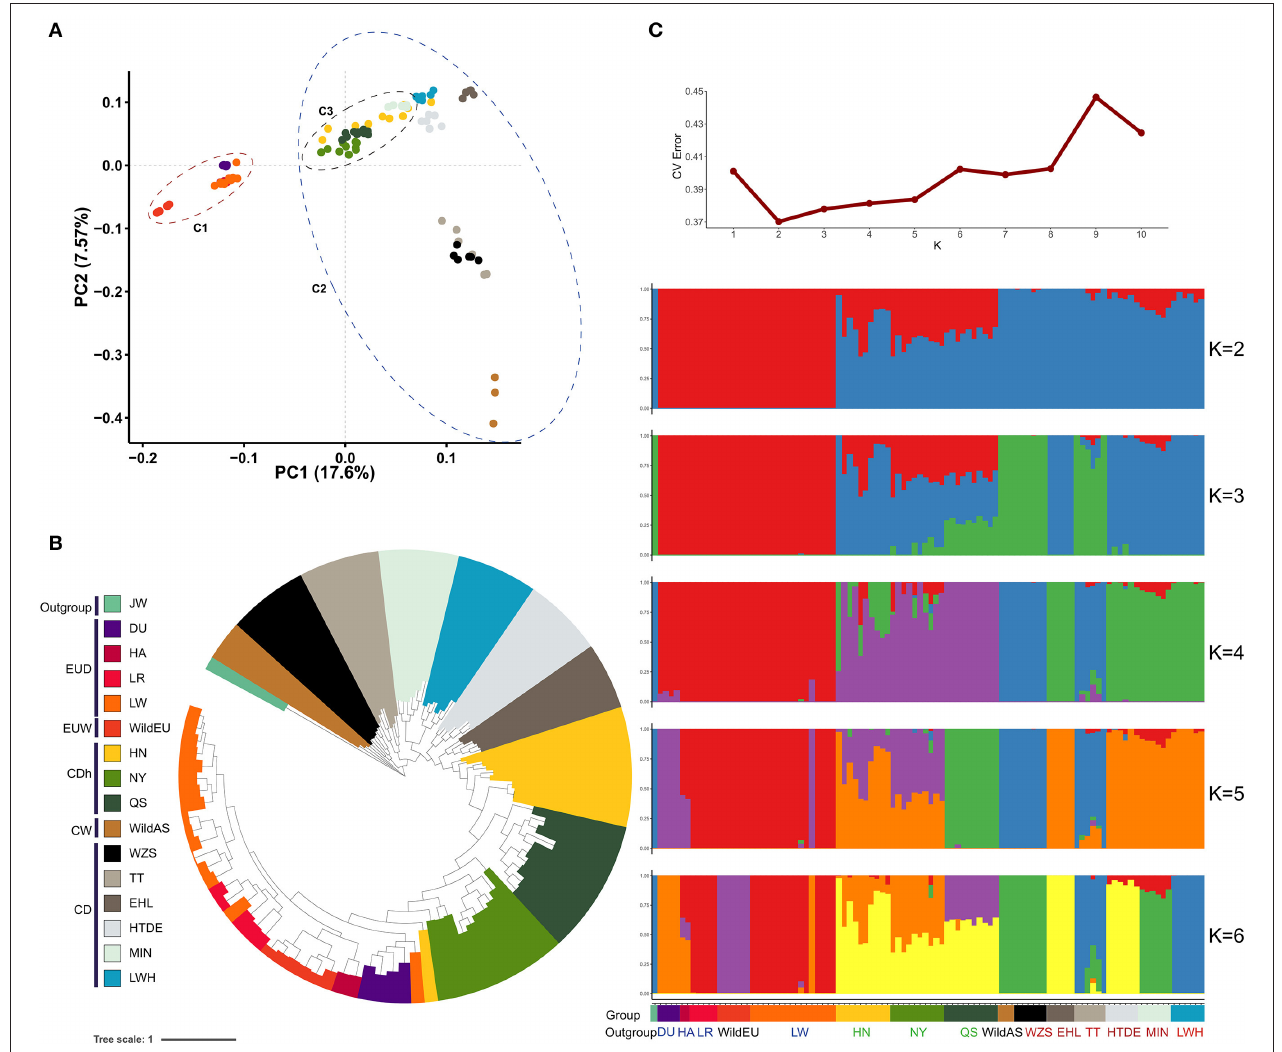
FIGURE 1 | Population structure and relationships. (A) Principal component analysis of Chinese and European pigs. C1, European pigs; C2, Chinese pigs; C3, Henan indigenous pigs. (B) Phylogenetic tree of Chinese and European pigs based on the GTR model. Group colors used in (A) are the same as (B) . (C) Population structure of Chinese and European pigs revealed by admixture analysis. JW, Java warty pig; DU, Duroc pig; HA, Hampshire pig; LR, Landrace pig; LW, Large White pig; WildEU, European Wild pig; HN, Huainan pig; NY, Nanyang pig; QS, Queshan pig; WildAS, Chinese wild pig; WZS, Wuzhishan pig; TT, Tibetan pig; EHL, Erhualian pig; HTDE, Hetao daer pig; MIN, Min pig; and LWH, Laiwuhei pig. All pigs were also classified as Chinese indigenous pig breeds (CD), European commercial pig breeds (EUD), Chinese wild pig populations (CW), European wild pigs (EUW), or Java warty pigs ( Sus verrucosus , the